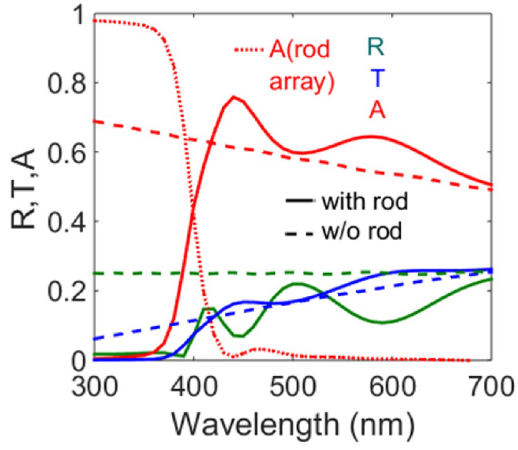
Figure 11. Absorption, reflection and transmission of an air dielectric (n = 3, k = 0.1) interface with periodic ZnO nanorod array (radius = 60 nm, length = 600 nm and pitch = 200 nm) as compared to a bare